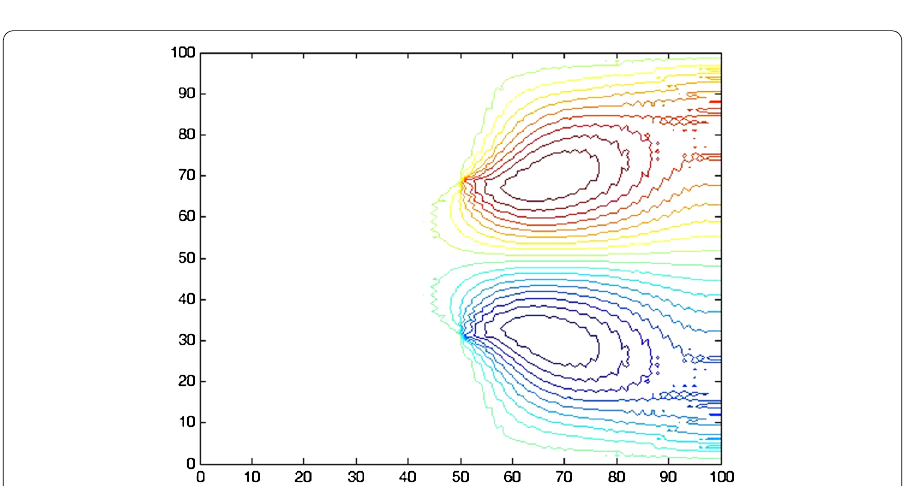
Figure 3 The component F 11 of the SMFE solution of the deformation tensor F at t =